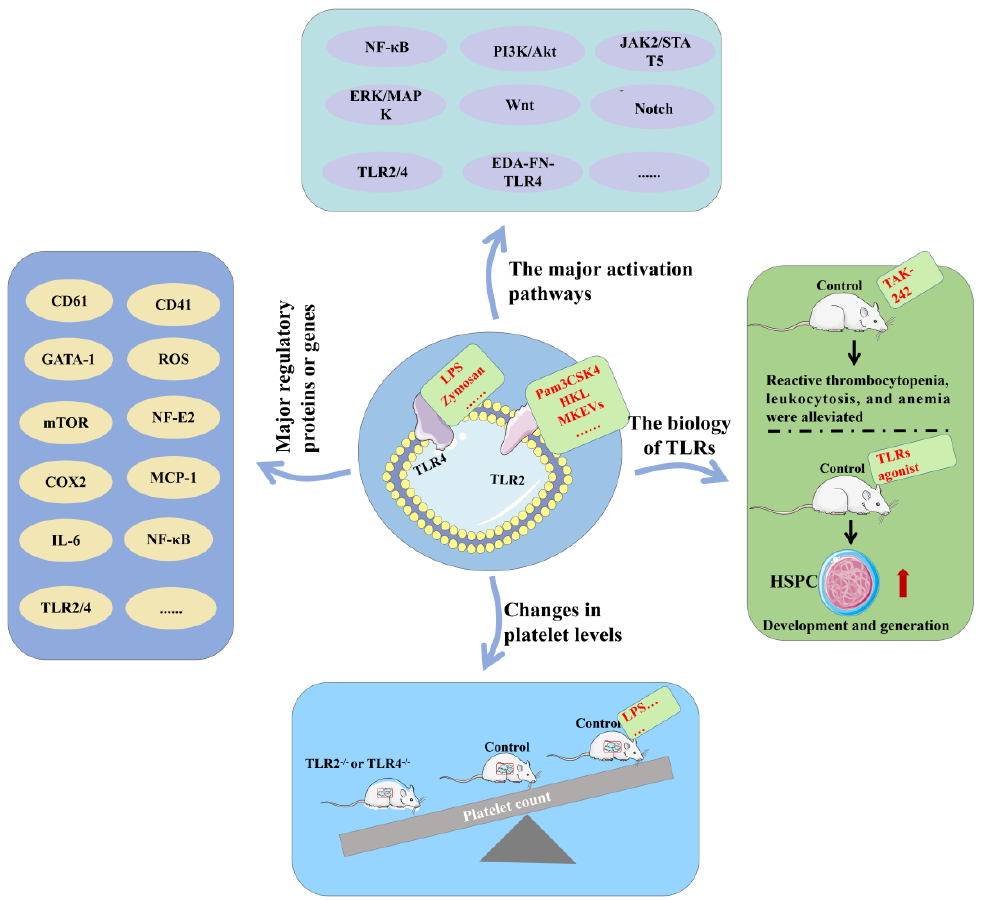
Figure 5. TLR2 and TLR4 promote platelet formation. TLR activation can activate multiple signaling pathways and increase the expression of related factors, thereby increasing the number of platelets. In vivo TLR inhibitor studies further confirmed that TLR activation can affect platelet production.